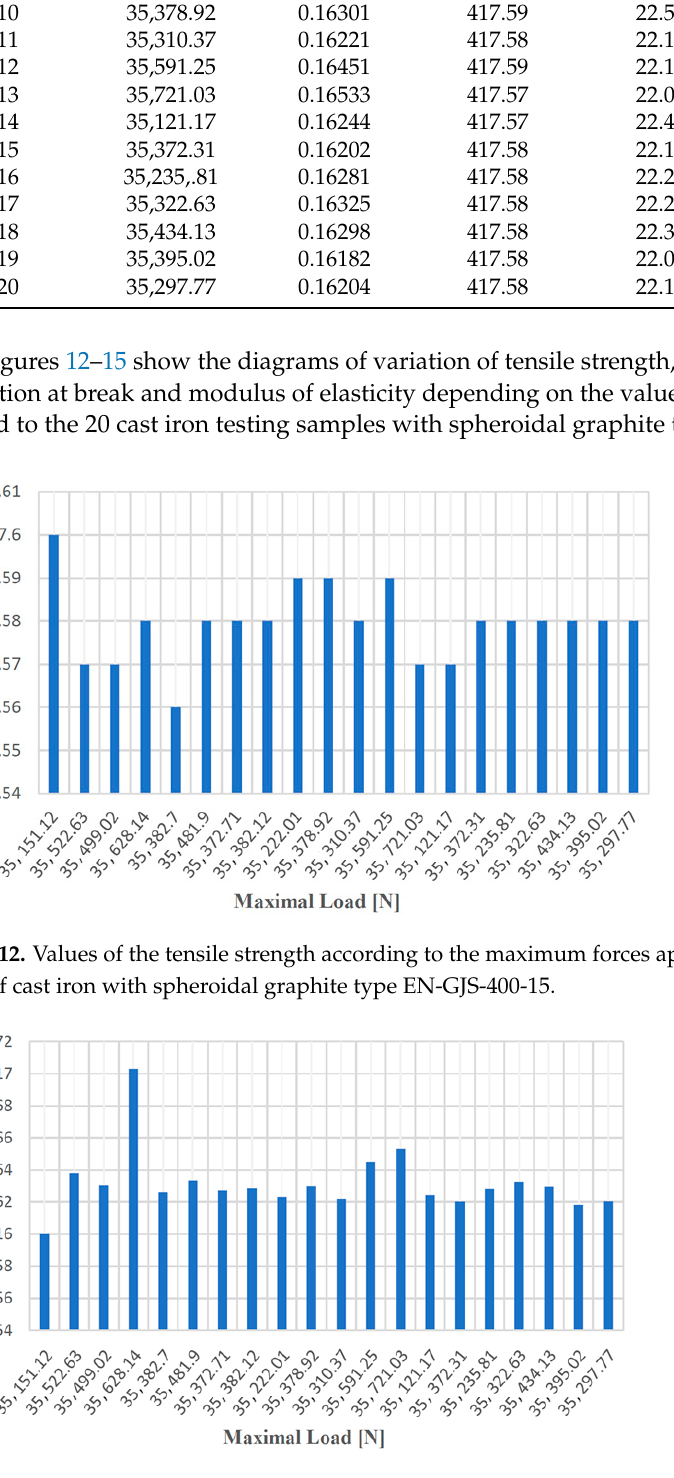
Figure 14. Elongation at break values at failure depending on the maximum forces applied to the 20 samples made of cast iron with lamellar graphite type EN-GJS-400-15. The values of the elongation at failure depending on the maximum forces applied to the 20 samples made of cast iron with spheroidal graphite type EN-GJS-400-15.